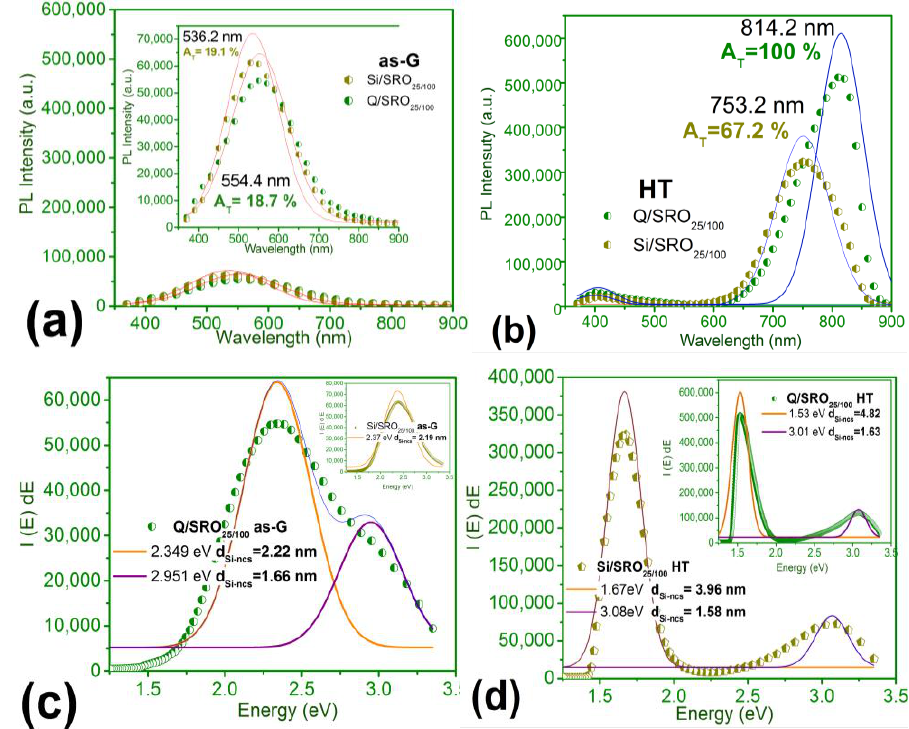
Figure 11. Photoluminescence of the SRO 25/100 films deposited by the HFCVD system under conditions ( a ) and ( c ) as-G and ( b ) and ( d ) with HT.